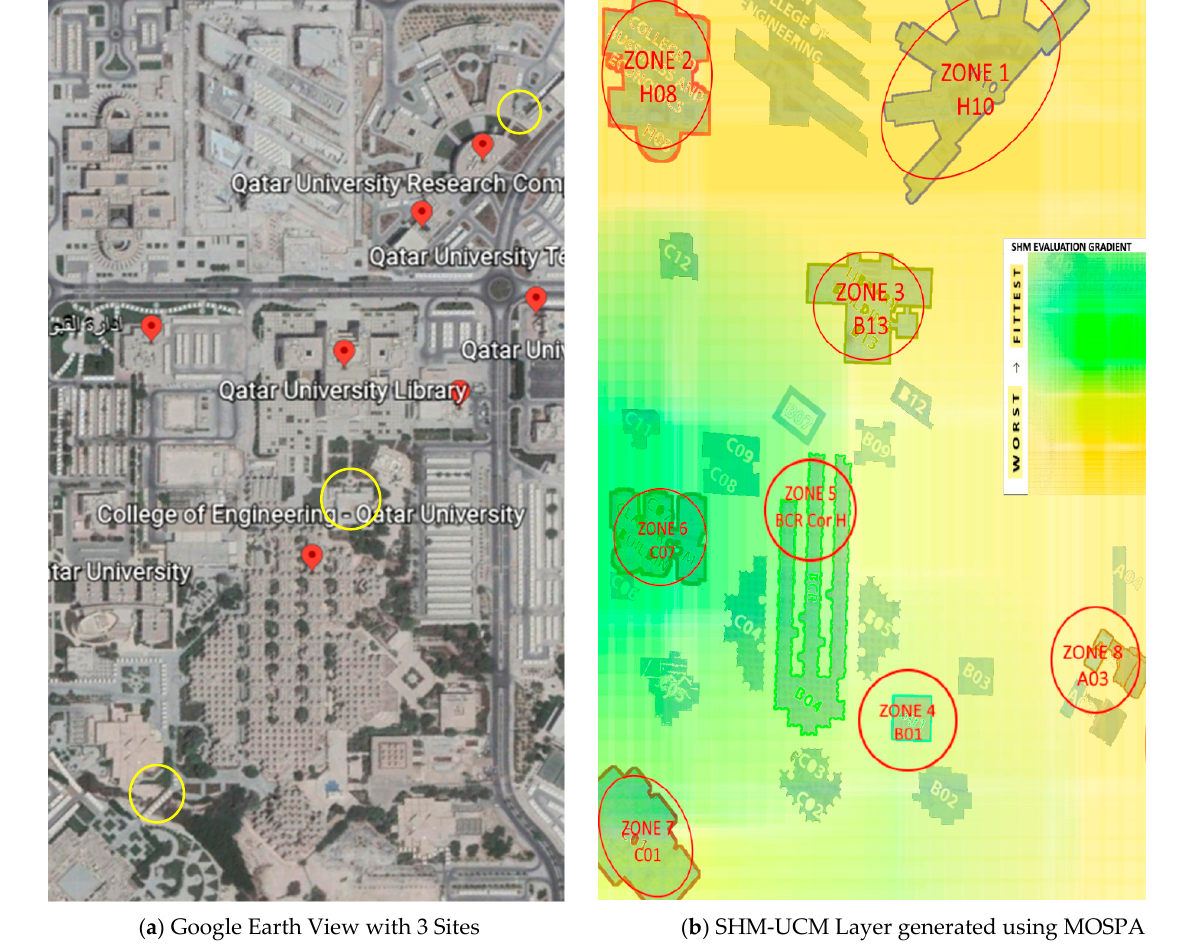
Figure 18. Qatar University SHM Proposed Evaluation diagram ( a , b ).